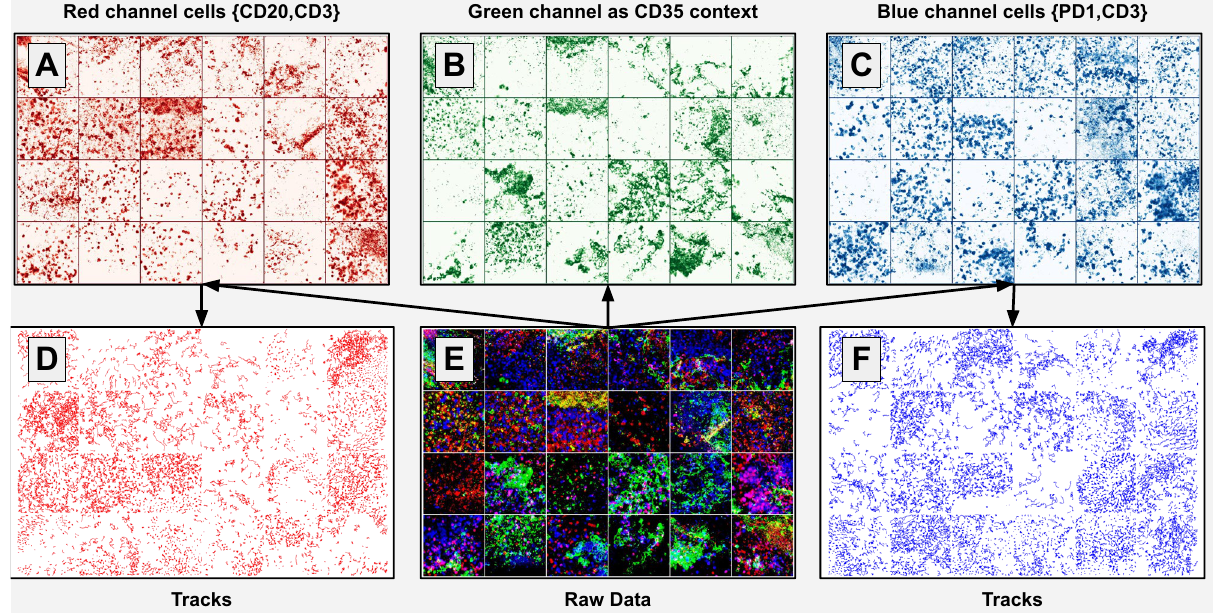
Figure 1. Unique 4D Dataset of lymphocytes inside fresh human lymphoid tissue sections. ( E ) represents the raw data (totaling 24 video sequences where only the first frame is shown). Each sample (i.e. a single video sequence) consists of three channels ( A – C ). Channel B shows CD35 positive follicular dendritic cells, which were used for context analysis. Channel A and C describe a single stain among T-cells (CD3), B-cells (CD20), and follicular T-helper cells (PD1). Moreover, from these channels, cell tracking data is extracted. Specifically, the cell tracks shown in ( D ) and ( F ) are computed from T- and B-cells, respectively. More details are described in “Material and